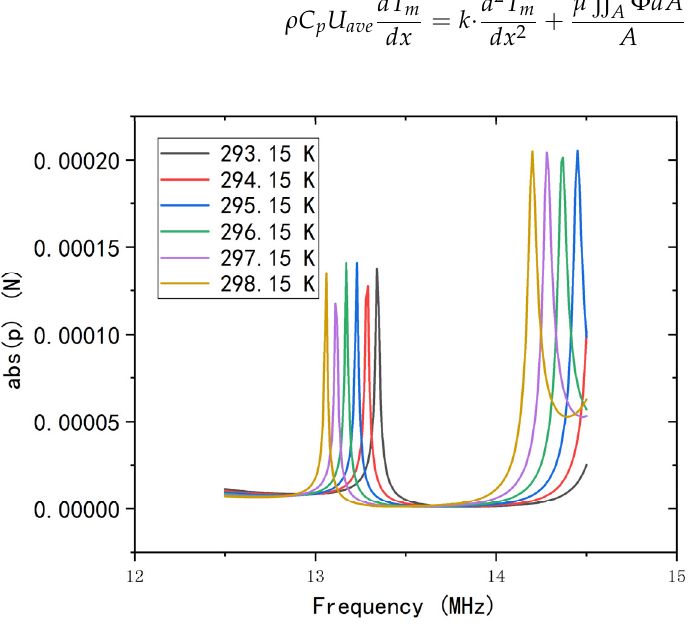
Figure 5. The change in the edge of the bandgap with changes in temperature, with a liquid sound velocity of 1500 m/s.